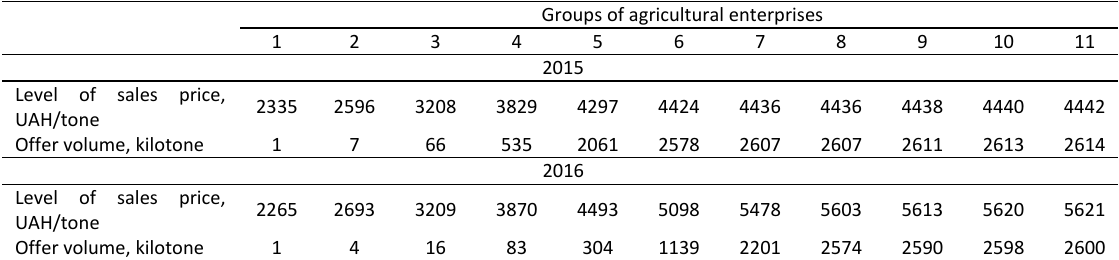
Table 3: Characteristics of the supply of milk agricultural enterprises for 2015-2016 years